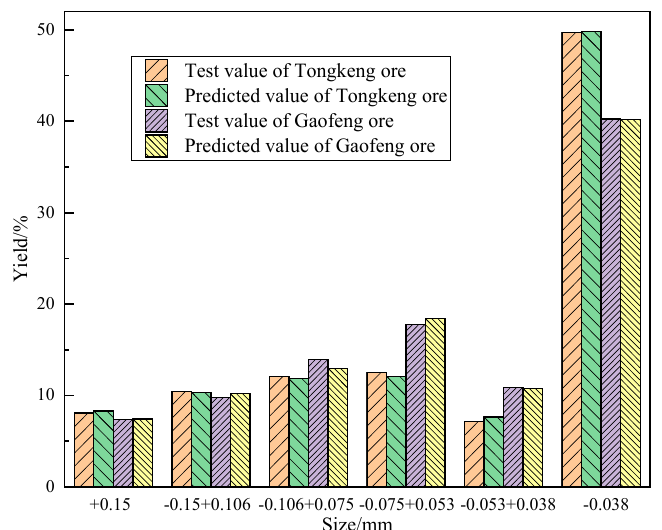
Figure 10. Prediction results of PSO–BP method for Tongkeng ore and Gaofeng ore. Table 10. Error comparison of Tongkeng ore and Gaofeng ore.